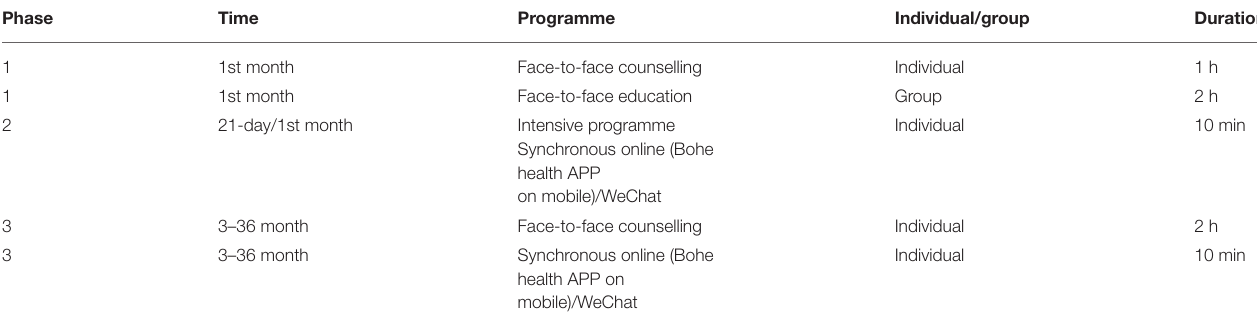
TABLE 1 | Multidisciplinary weight management